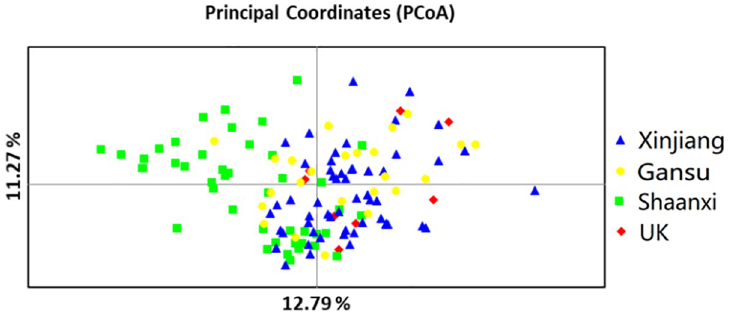
Fig 5. Principal coordinate analysis of Venturia inaequalis isolates sampled in Shaanxi, Gansu and Xinjiang, China, and in the U.K. Notes: First axis = 12.79% of total information and second axis = 11.27%.